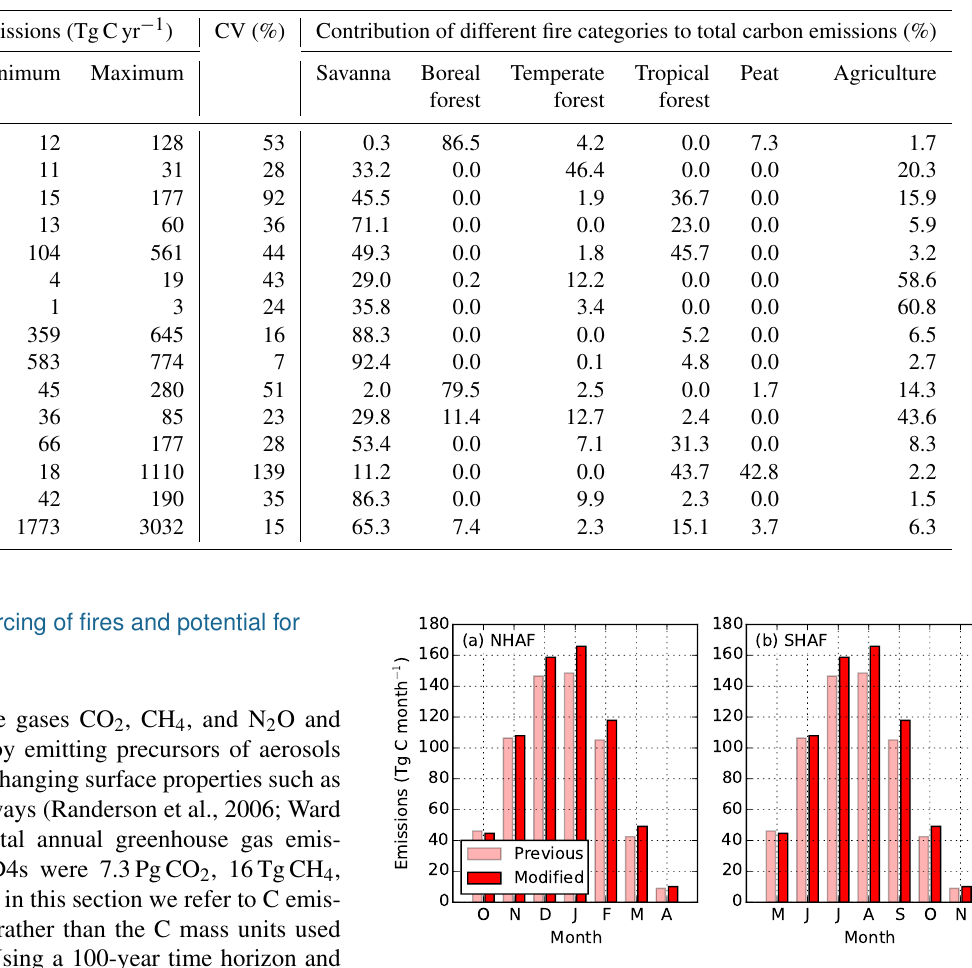
Figure 11. Monthly GFED4s fire carbon emissions for Northern Hemisphere Africa (a) and Southern Hemisphere Africa (b) based on straight conversion of burned area to burned fraction (“pre- vious”) and with the new parameterization according to Eq. (3)